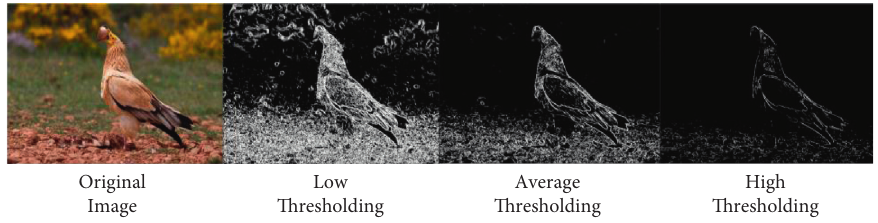
Figure 2: Impact of the threshold in local integral pattern